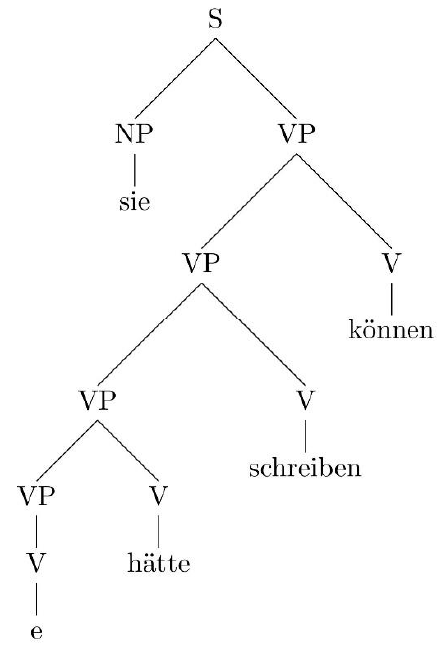
Figure 16. Derived tree with V extraposition .